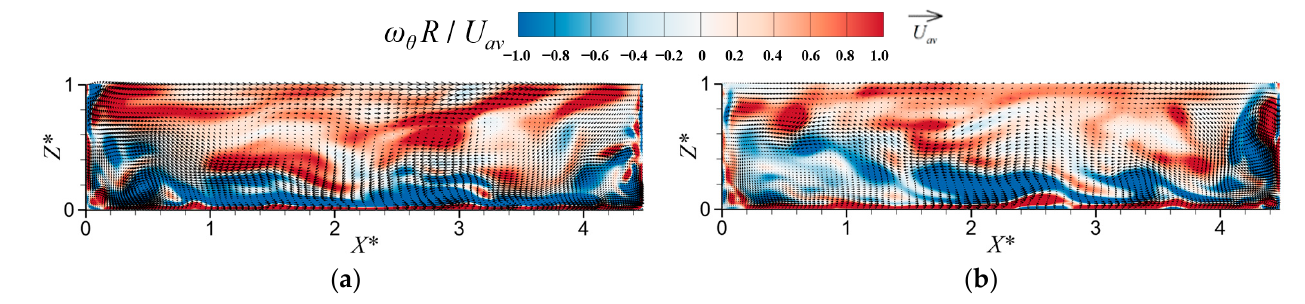
Figure 15. The normalized instantaneous velocity vectors and streamwise vorticity. ( a ) Section #04 in Case S1–S10; ( b ) and Section #07 in Case S1–S10.